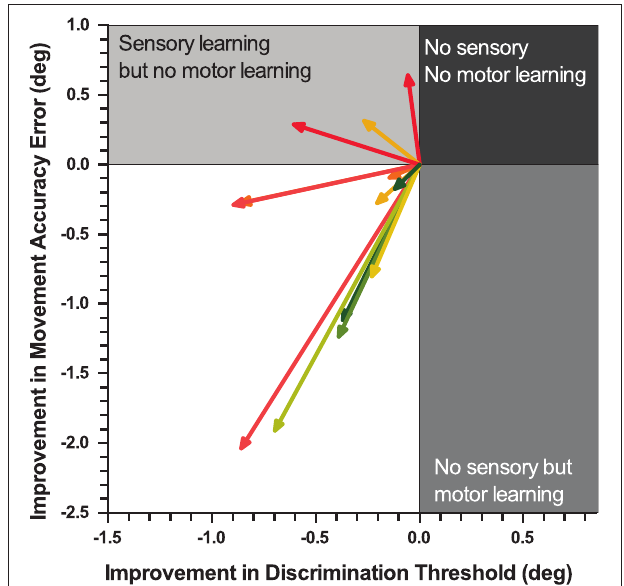
FIGURE 5 | Vectorgram mapping gains in proprioceptive acuity against gains in movement accuracy. Each vector depicts a participant’s sensorimotor gain. The coordinates of proprioceptive discrimination threshold and movement accuracy error score are aligned to the origin. The length of the vector indicates the magnitude of relative change and the angle the direction of